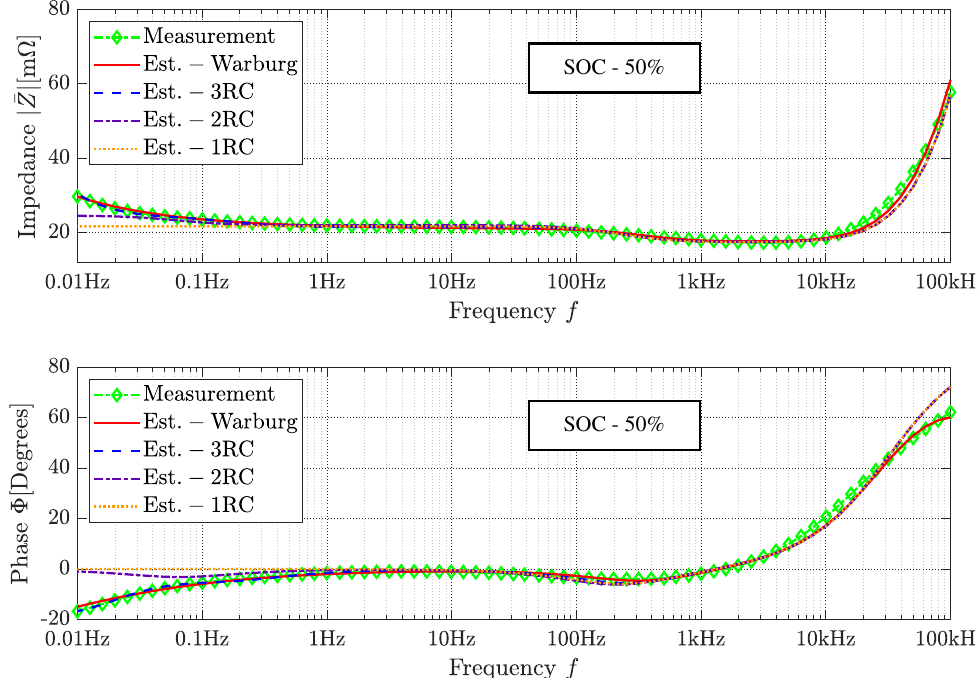
Figure 6. Obtained Bode plot from EIS measurements (green) in comparison to the parameterized Warburg impedance (red) and three- RC -pair (blue) model for a cylindrical 18650 battery cell from LG Chem of model type HG2 with a nominal capacity of